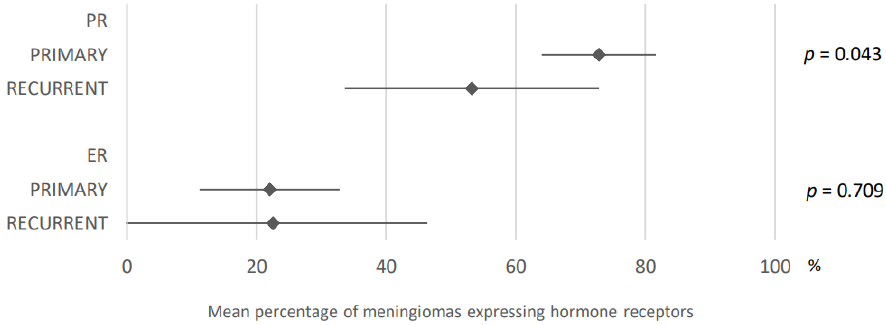
Figure 12. Comparison of hormone receptors expression in meningiomas according to their primary or recurrent nature. PR: progesterone receptors; ER: estrogen receptors. The results are expressed as a mean associated with their 95% confidence interval. Number of articles analyzed related to the